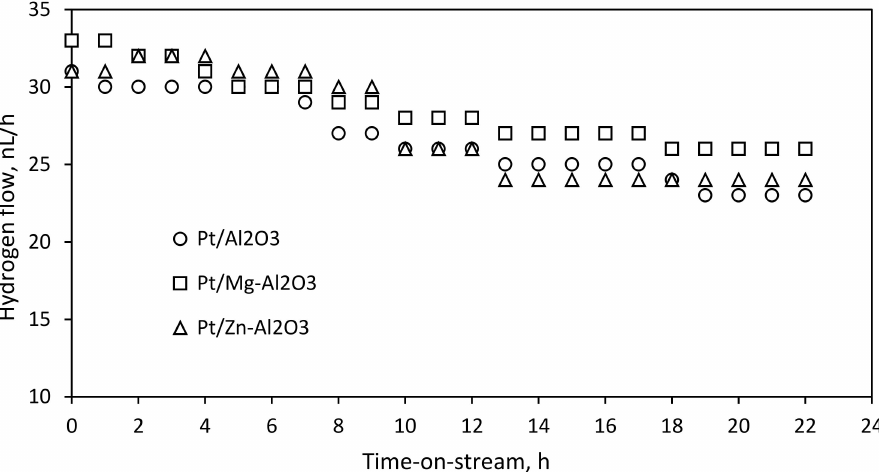
Figure 1. Hydrogen flow rate vs. time-on-stream for dehydrogenation of H18-DBT over 22 h. Reaction parameters: Pt loading 0.5 wt.%, H18-DBT degree of hydrogenation (doh) 99.6%,